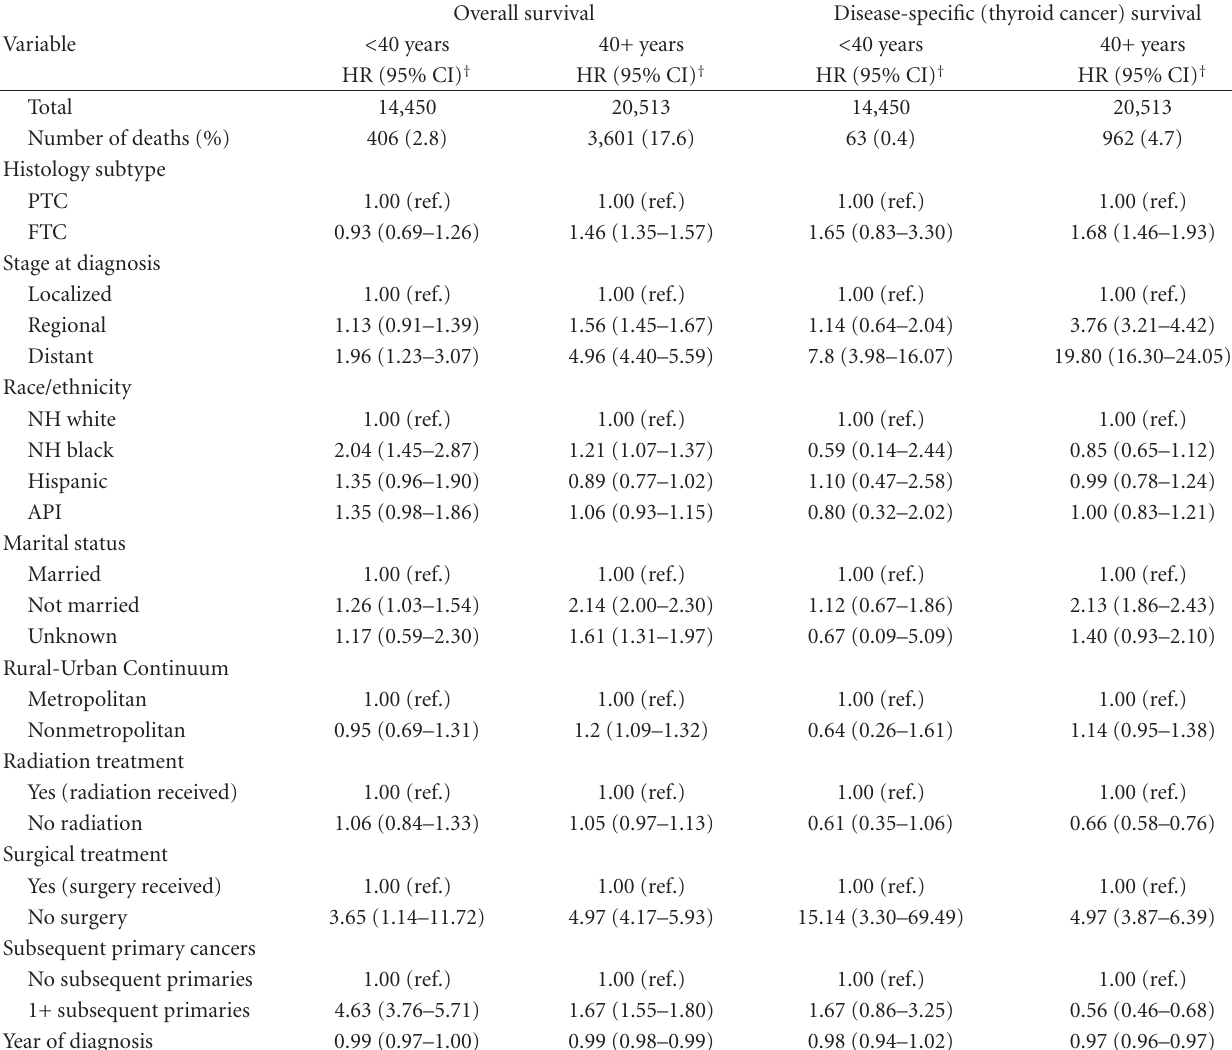
Table 2: Multivariate Cox PH regression analyses 1975–2009 (SEER 9 ∗ ): overall and disease-specific survival by age group.